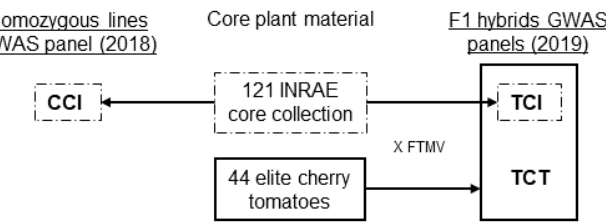
Figure 1. Plant materials in the three GWAS panels. We built the panels starting from the homozygous core plant materials. We studied the INRAE core collection in 2018 at the line level (CCI). We then studied a test cross in 2019 (TCT) obtained from the overall core plant materials crossed with the same big fruited tester FTMV. To compare the core collection at the line and F1 hybrid levels, we extracted the test cross carrying only the core collection F1 hybrids (TCI) from the TCT panel and studied this third panel independently.